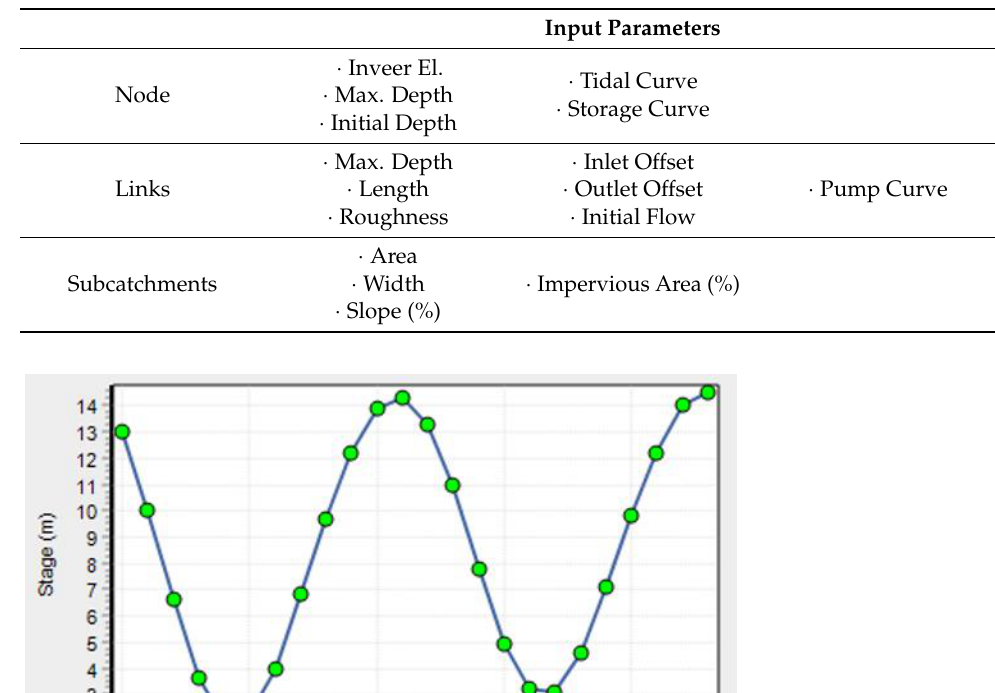
Table 2. Main Input Parameters of SWMM.